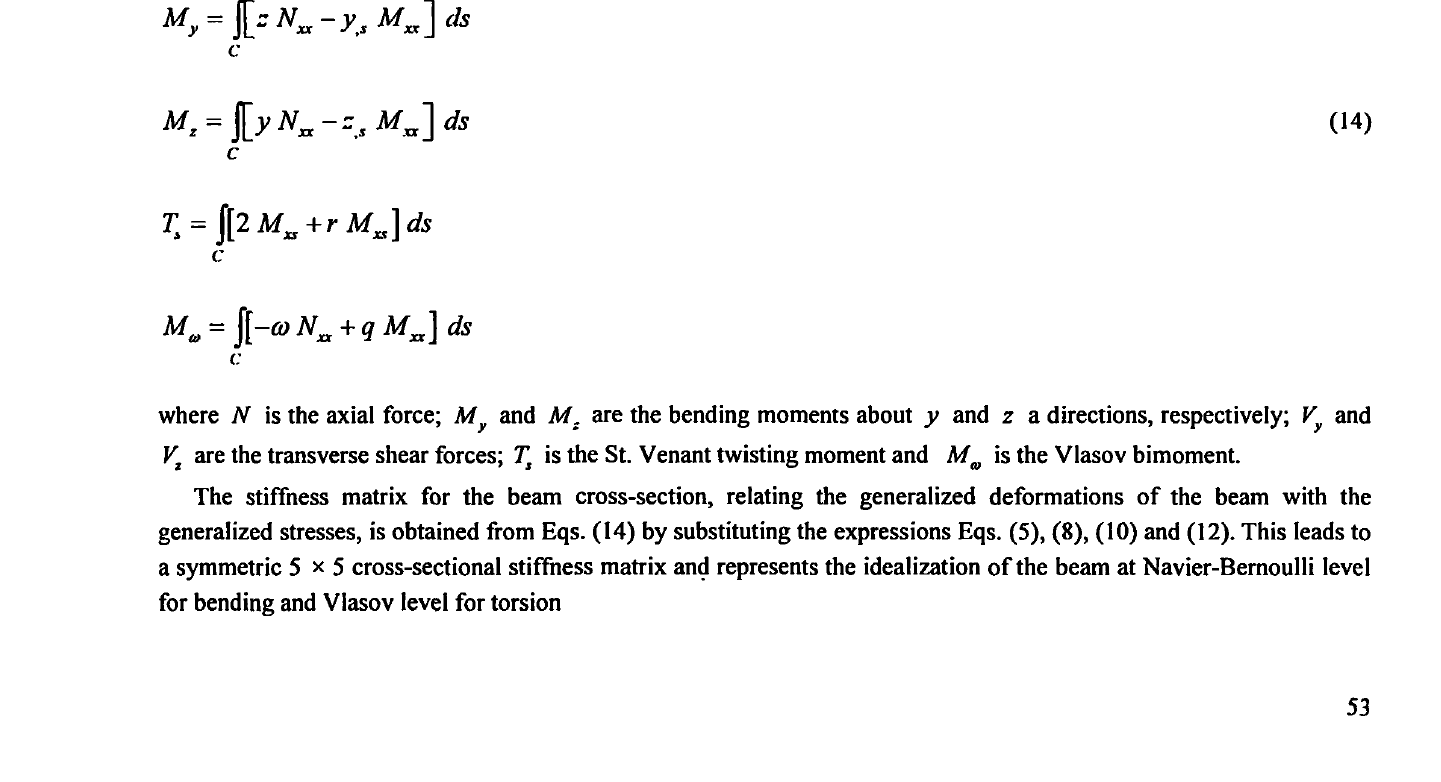
Fig. 3: Generalized beam forces and